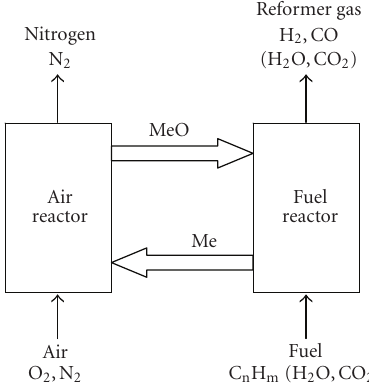
Figure 6: Schematic description of chemical-looping